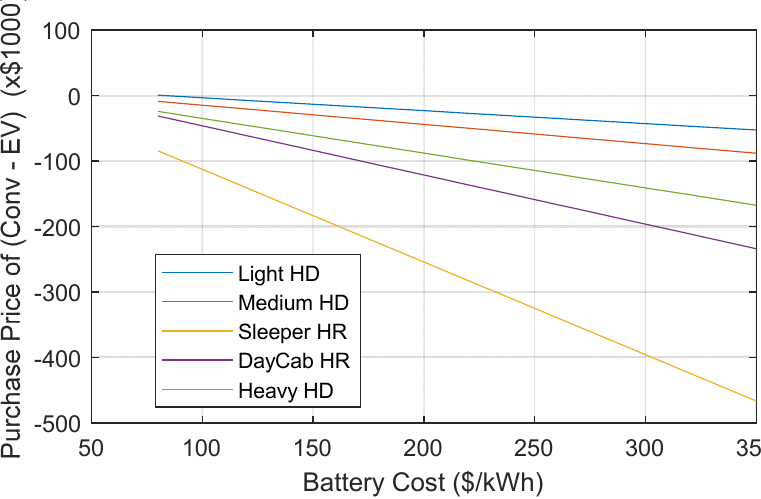
Figure 2. Purchase price parity comparison of all vehicles considered in this study.